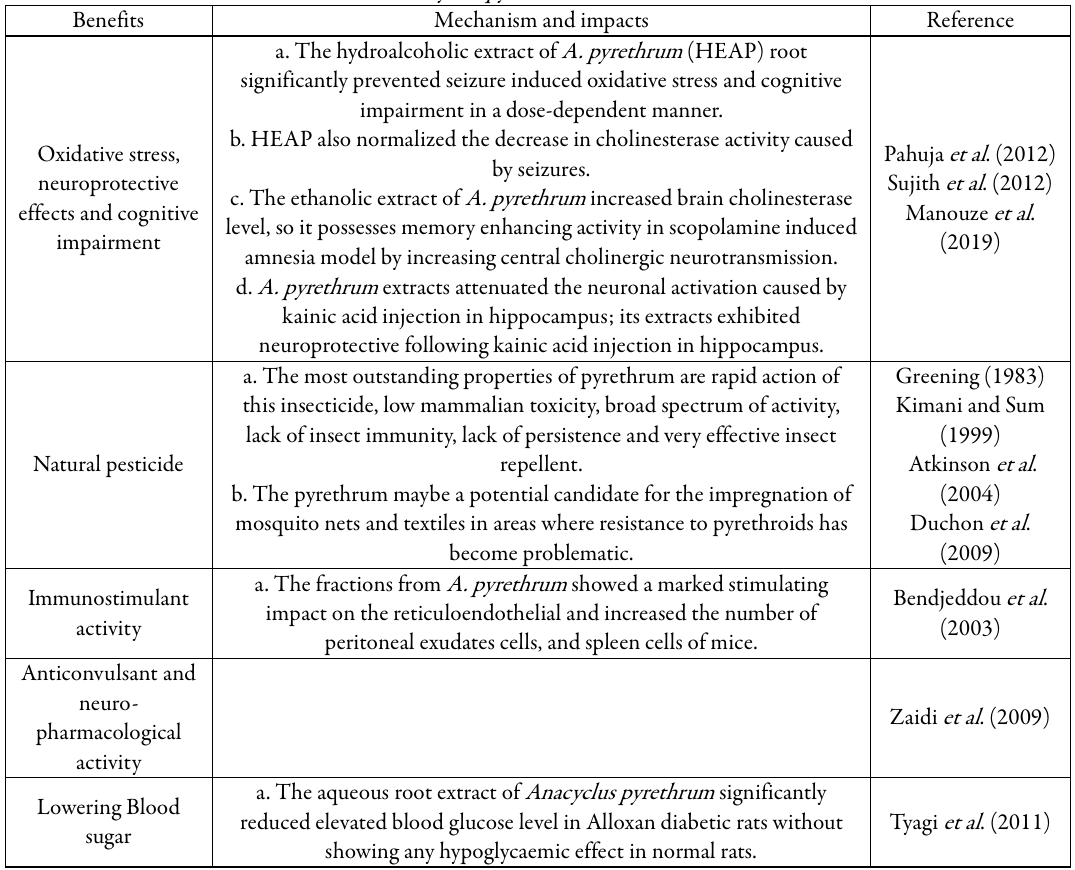
Table 2. Pharmaceutical benefits of Anacyclus